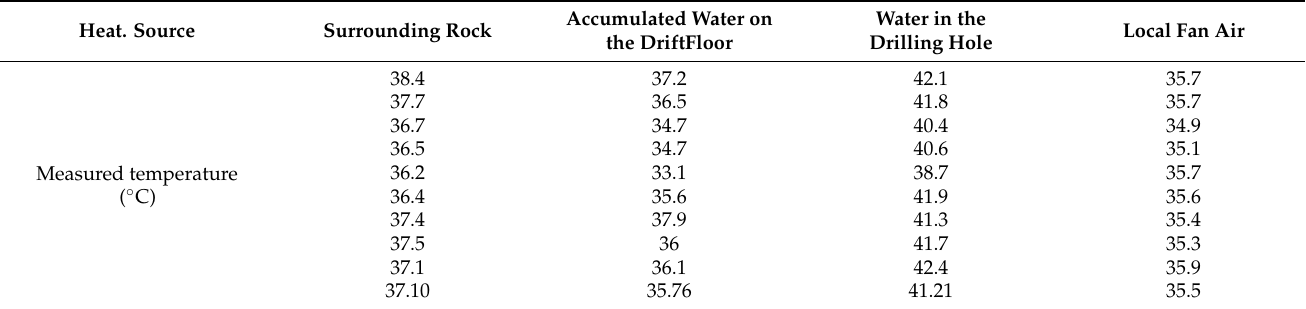
Table 1. Measured Temperature of Each Heat Source.